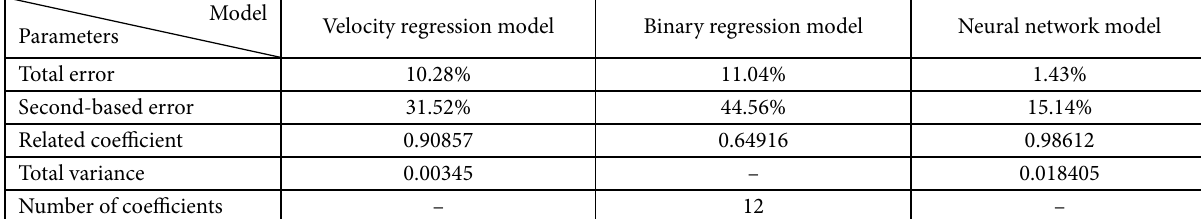
Table 8. CO emission model error